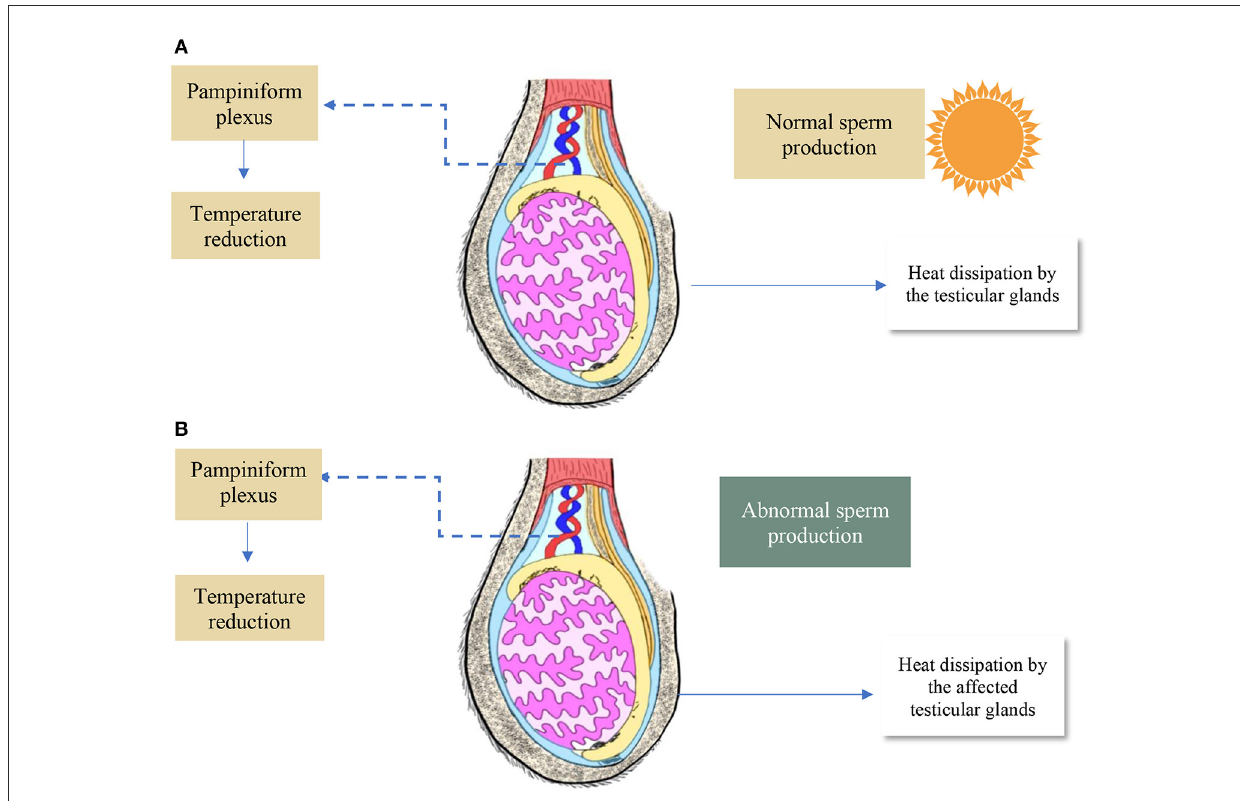
FIGURE11 Bovine testis. (A) Morphological characteristics of the testis without heat stress. (B) Morphological characteristics of the testis under heat stress.